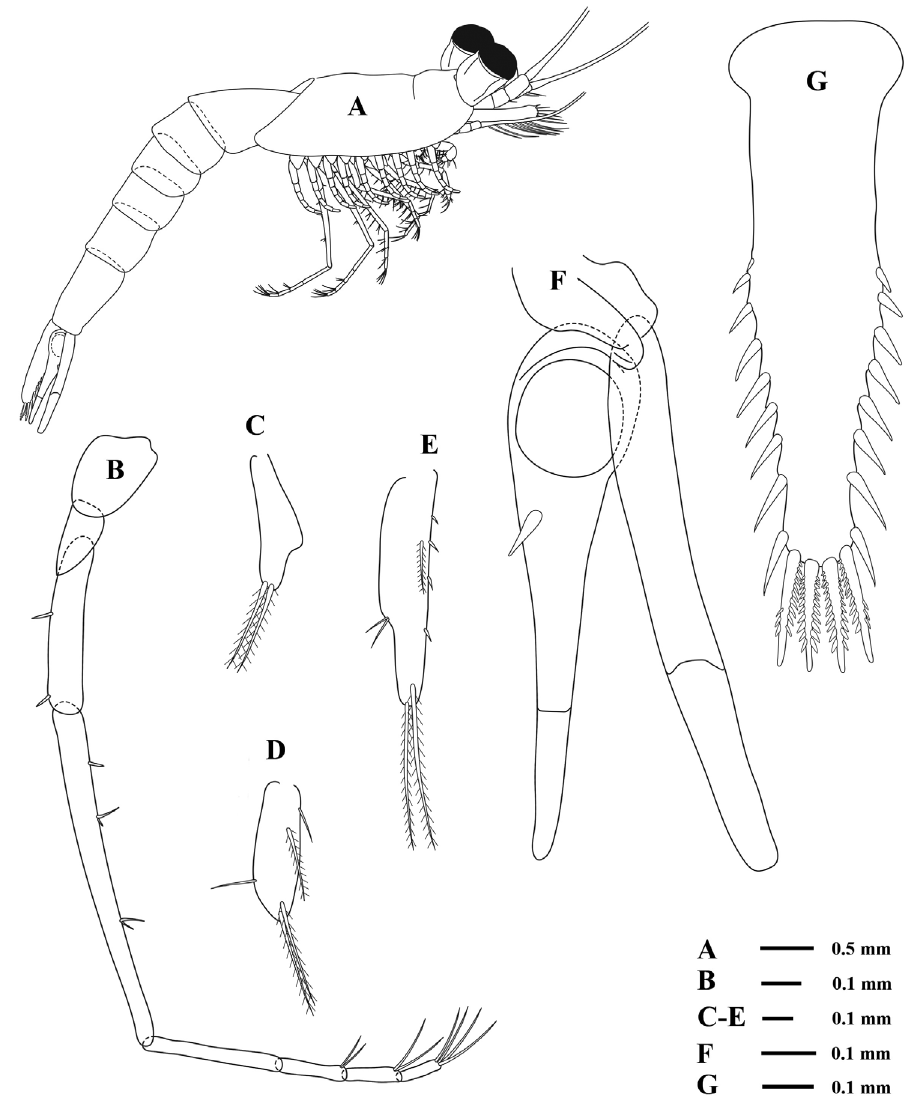
Figure 5. Rhopalophthalmus longipes ; A immature female (lateral view) B endopod of seventh pereopod C first pleopod D third pleopod E fifth pleopod F right uropod G telson. fourth one, carpo-propodus divided into three articles, basal article sub-equal or slight- ly longer than the carpo-propodus; endopod of fourth to sixth pereopods (Figs 4D, 4E, 4F) having three-segmented carpo-propodus; endopod of seventh pereopod (Fig. 5B) longest, approx. 2½ times as long as the exopod, carpo-propodus divided into four articles, carpus noticeably long, as long as or longer than pereopod normally un- articulated, barely reaching mid-length of basal plate of